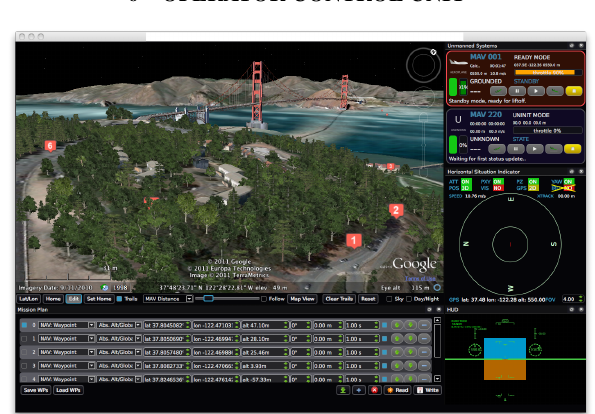
Figure 10: Operator perspective using the 3D moving map with elevation data and city 3D